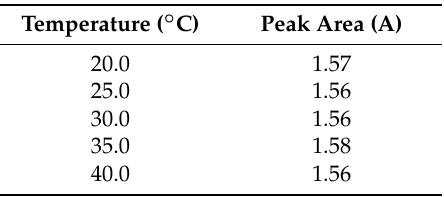
Table 1. Effect of temperature on the adsorption of Tyr amino acid on GO.